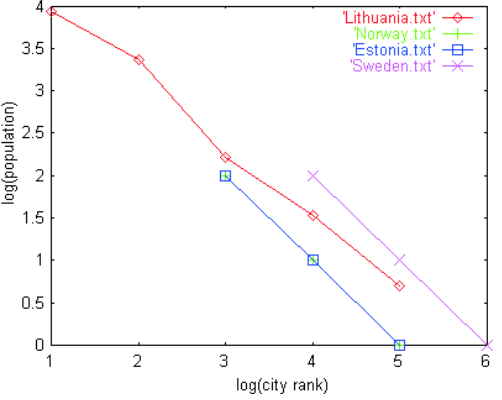
Figure 2. Power law in urban systems: log ( rank of cities ) = − τlog ( population )